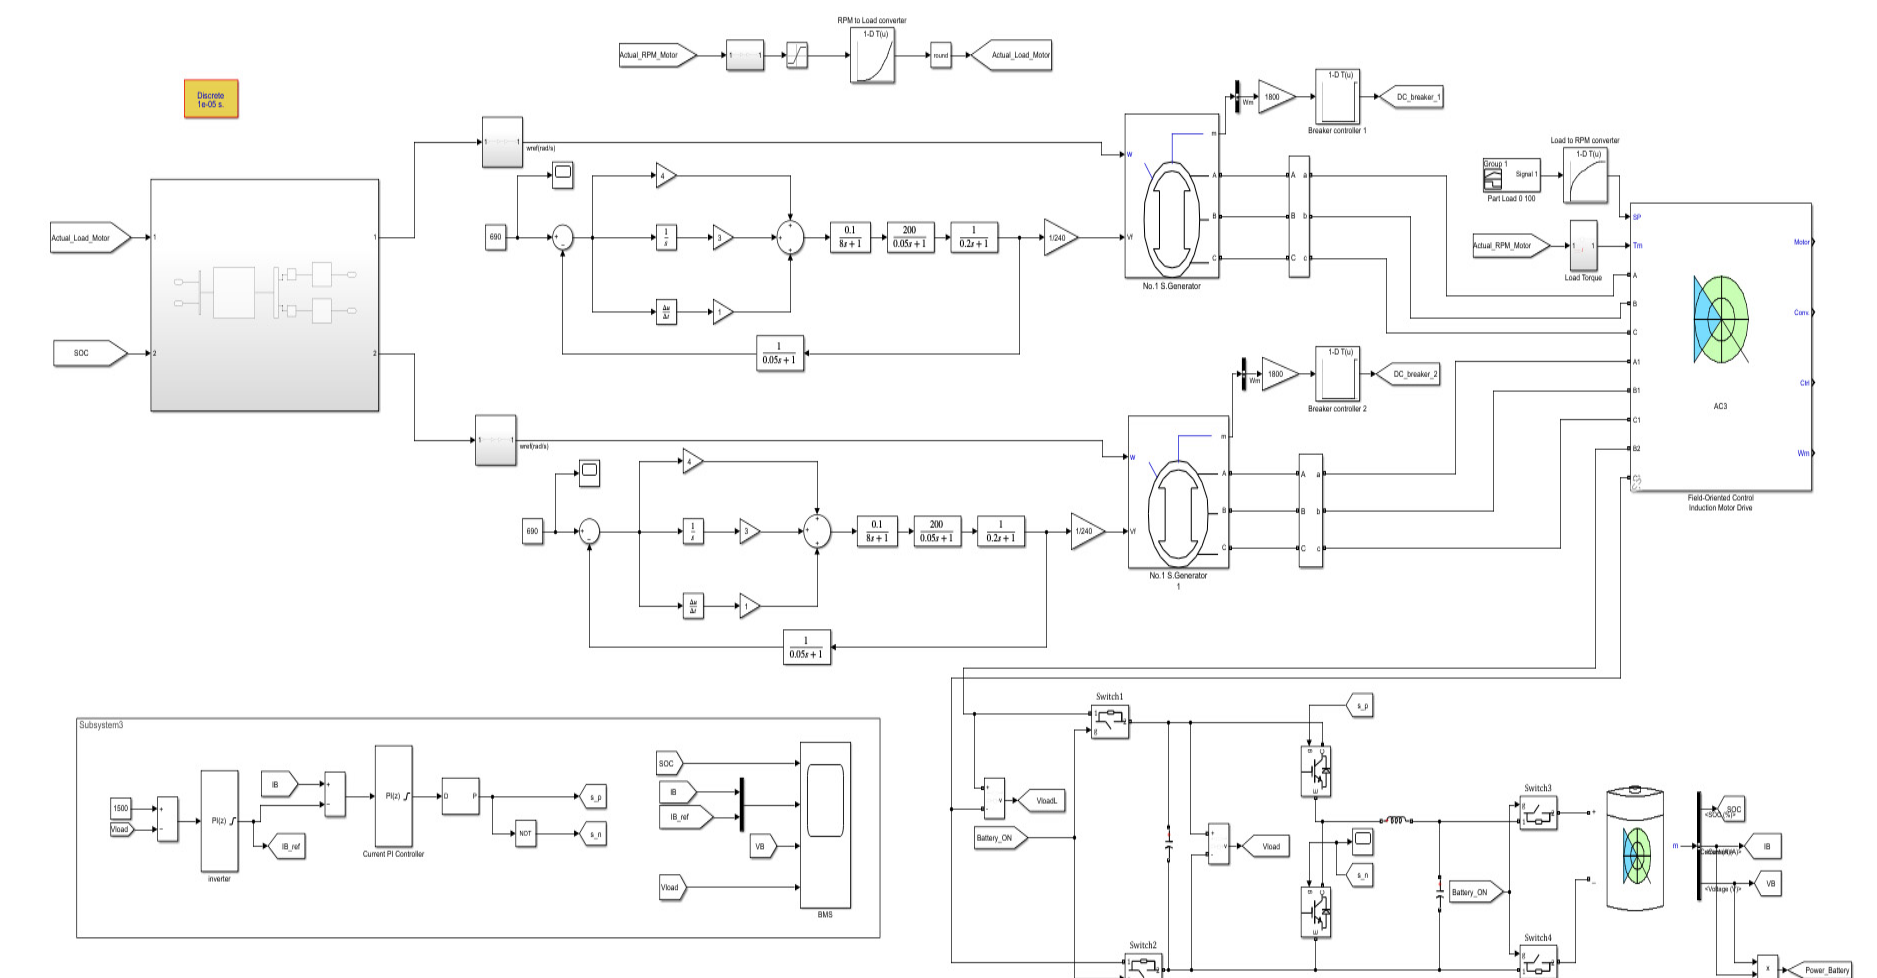
Figure 15. Simulation model of generator–battery hybrid system architecture using neural network in vessel.